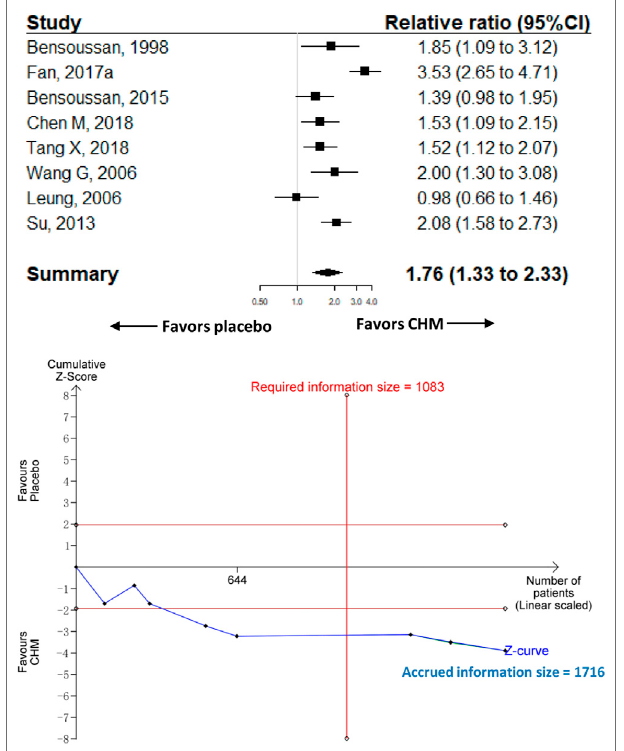
FIGURE 3 | Meta-analysis and TSA analysis of CHM vs. placebo in the relief of abdominal pain. CHM, Chinese herbal medicine. TSA, trial sequential analysis. The results of meta-analysis were shown on the top half, and the results of TSA were shown on the bottom half. The red vertical line represented the RIS for the comparison, assuming a difference of 20% in the rate of the relief of abdominal pain. The blue line represented the cumulative Z curve, and the black dots represented the included studies added according to their publication year in ascending